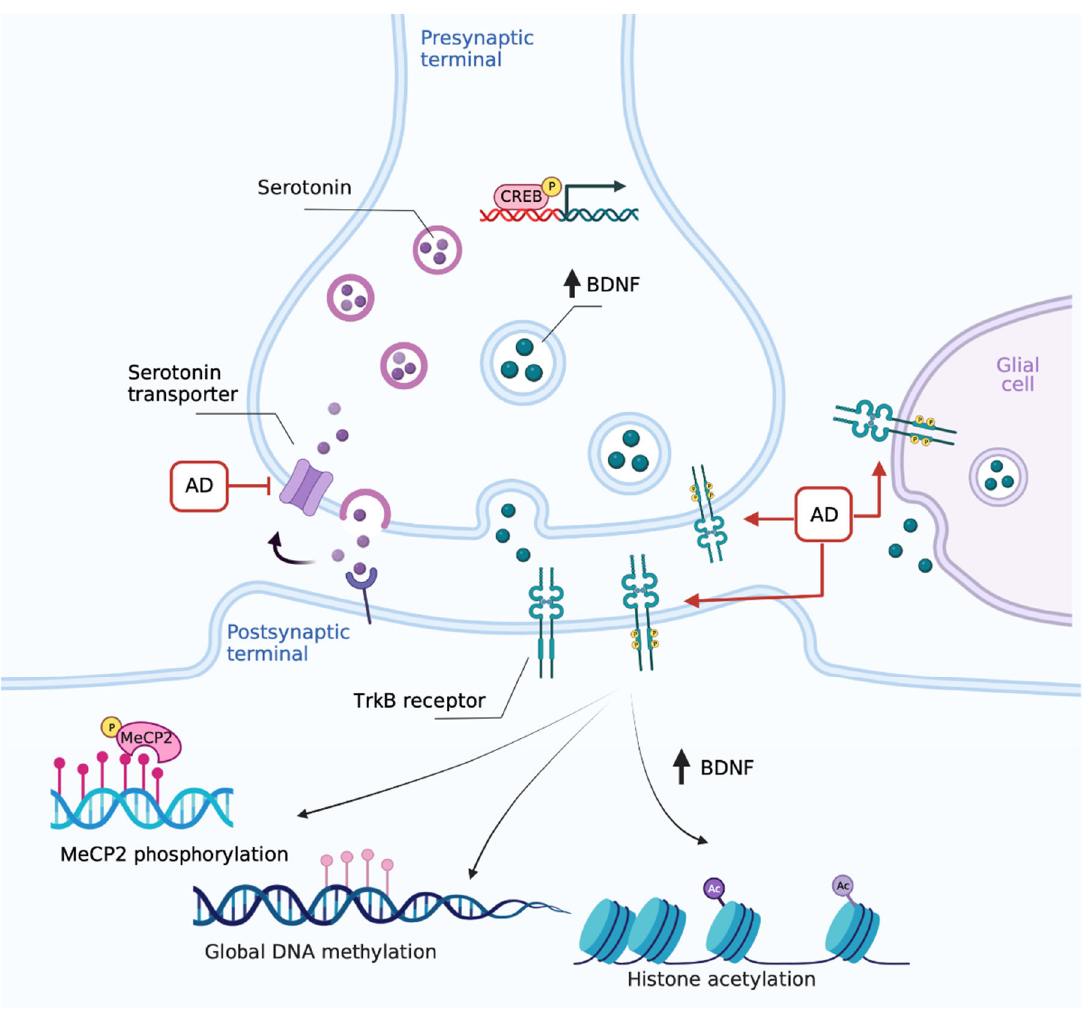
Figure 1. The paradigm shift in antidepressants’ mechanism of action: focus on TrkB. Chronic monoaminergic antidepressants (AD) increase hippocampal and cortical BDNF levels promoting autocrine/paracrine mechanisms, which include the direct interaction with TrkB and CREB-mediated upregulation in serotonergic terminals. Created with BioRender.com.